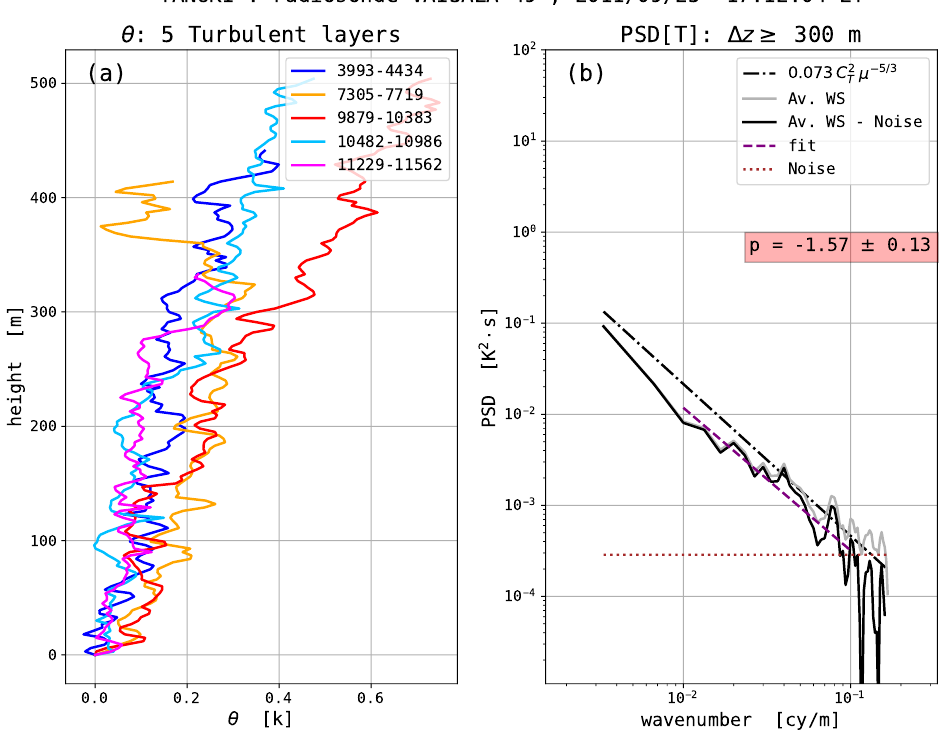
Figure 7. ( a ) PT profiles of the five unstable layers thicker than 300 m for flight T11-49. All profiles are shifted in order to be zero at the bottom of the layers. ( b ) The averaged spectrum (geometric average) is the grey curve. The corrected spectrum (after subtraction of the noise level) is the black curve. The dot-dashed line shows the shape and level of the OC spectrum with C 2 experimental spectra. The dotted horizontal line shows the noise level estimated by assuming a white noise. The dashed line shows the linear fit for the 10–100 m range of scales, while the slope ± standard deviation is indicated in the colored